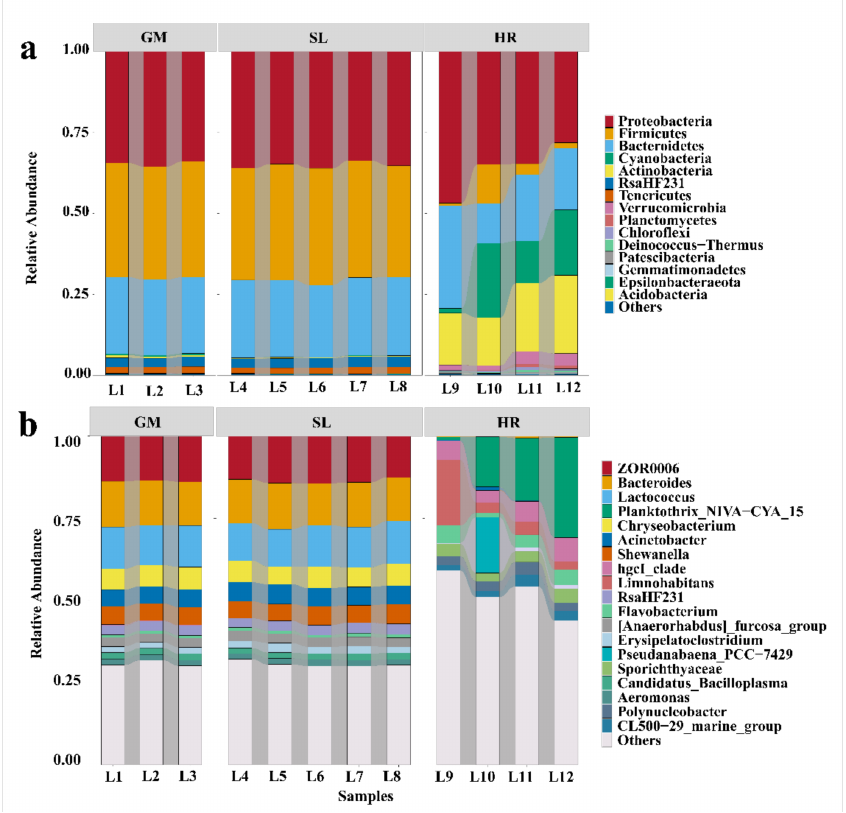
Figure 3. Relative abundance of reads of bacteria at the phylum ( a ) and genus ( b ) levels in the water samples; SL: subsidence lakes; GM: coal gangue mountain waters; HR: Huihe River.